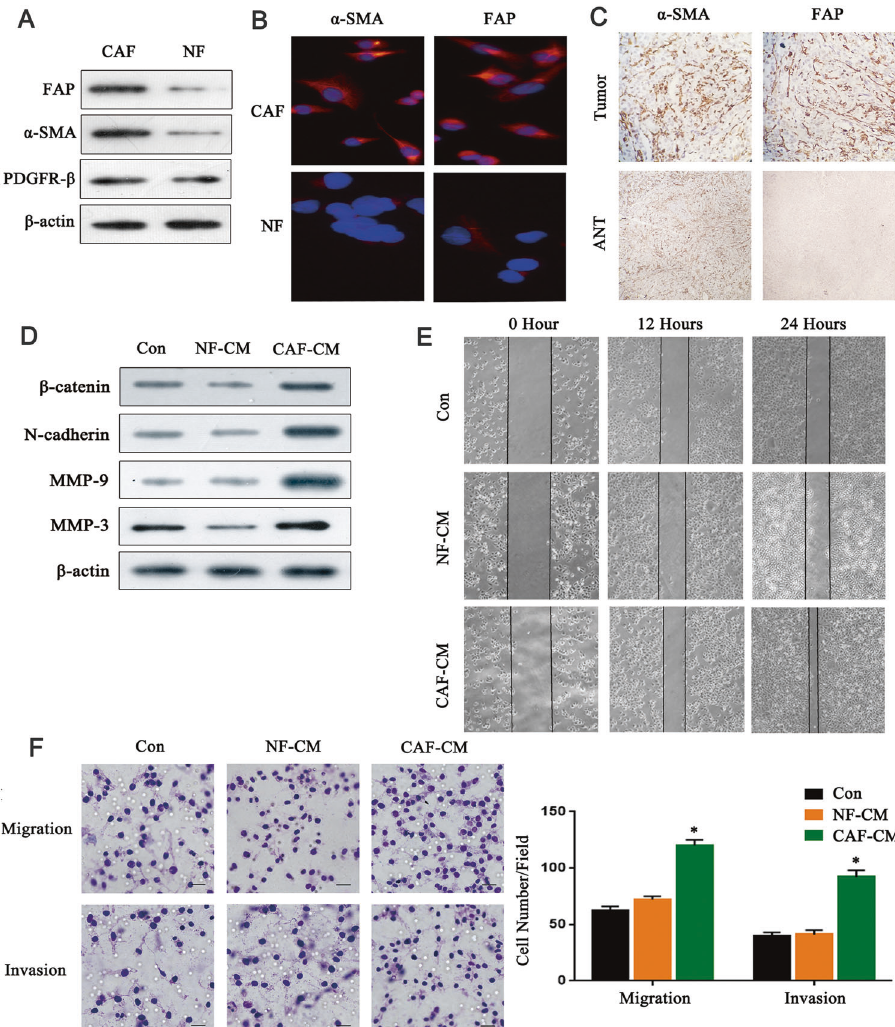
Fig. 1 CAFs promote the migration and invasion of breast cancer cells. A Western blot analysis of FAP, α -SMA, and PDGFR- β proteins in isolated fi broblasts ( n = 3). B Immuno fl uorescence analysis detected the expression of α -SMA and FAP in isolated fi broblasts. Scale bar, 50 μ m. C Immunohistochemical staining analysis of α -SMA and FAP expression in breast cancer tissues and adjacent normal tissues. Scale bar, 200 μ m. D MDA-MB-231 breast cells were co ‑ cultured with NF-CM or CAF-CM. The protein of MDA-MB-231 breast cells was extracted and detected the expression of β ‑ catenin, N-cadherin, MMP ‑ 9, and MMP ‑ 3 by western blot. E The effect of CAFs and NFs on the migration of breast cancer cells was analyzed by scratch experiment. F Transwell invasion assays analyzed the effection of CAFs and NFs on the invasion ability of breast cancer cells ( n = 3). Scale bar, 30 μ m. * indicates p < 0.05. The measurement data were expressed using mean ± SD, and the experiment was repeated three times; one-way ANOVA was used for multiple groups of data